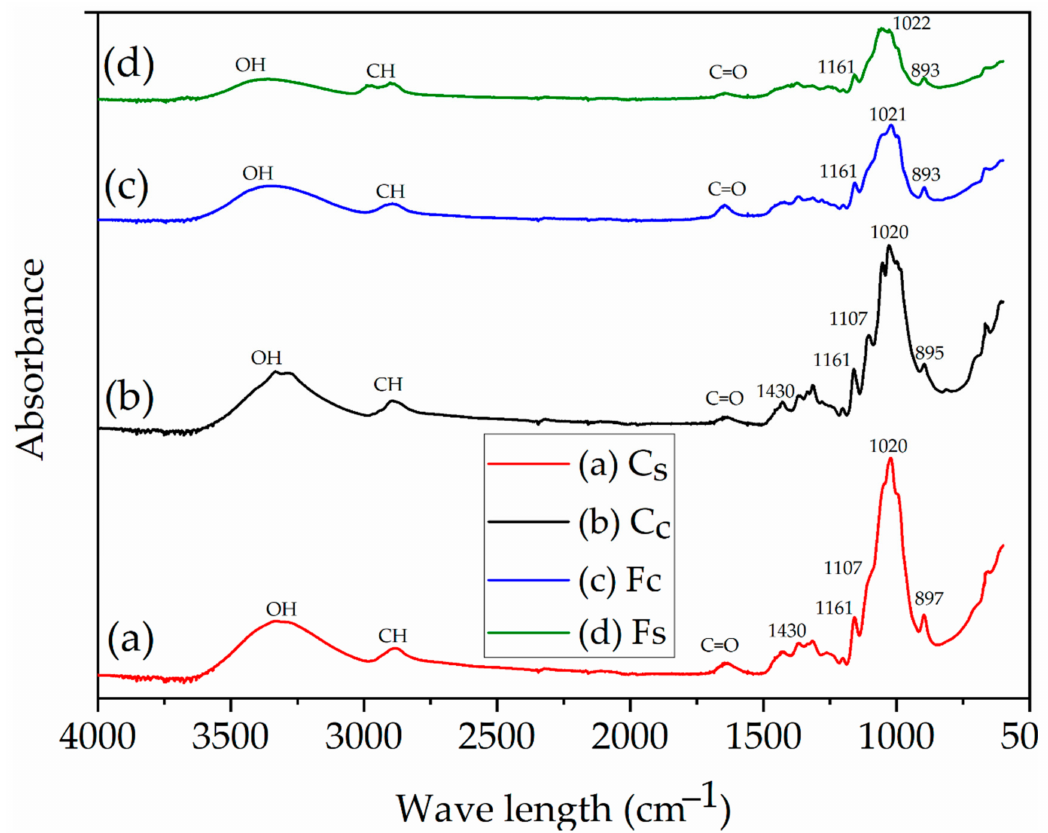
Figure 2. The Fourier transform infrared spectra of cellulose powders (C s , (a), red and C c , (b), black) and wet-spun CA fibers (F c , (c), blue and F s , (d)